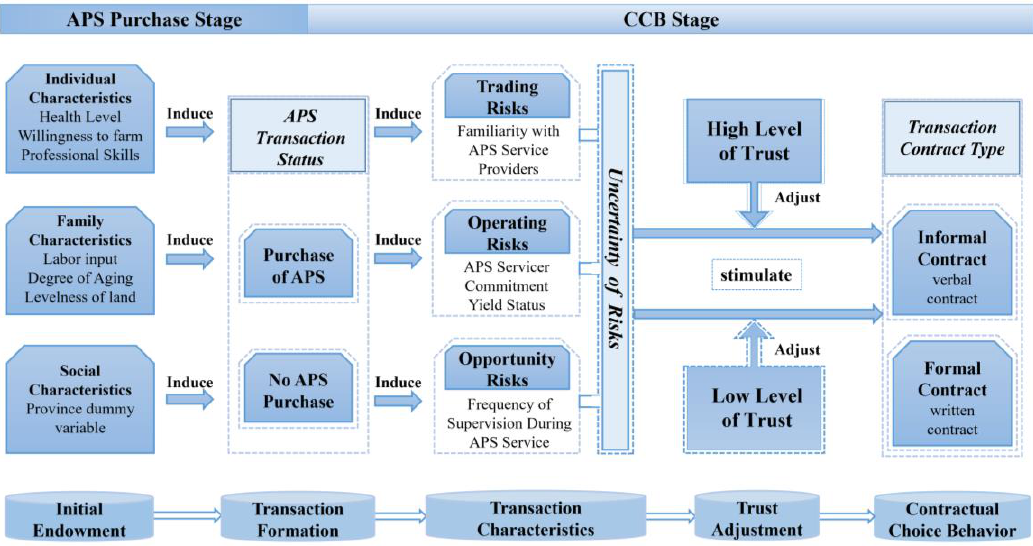
Figure 1. Two-stage theoretical framework of APS purchase – CCB under the role of RU.